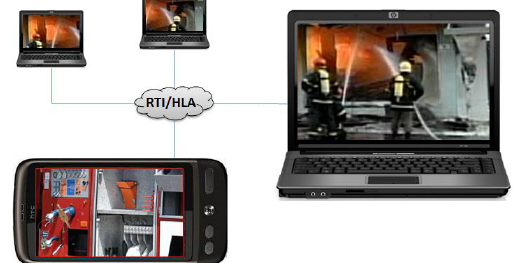
Figure 7. Overview of layer architecture.